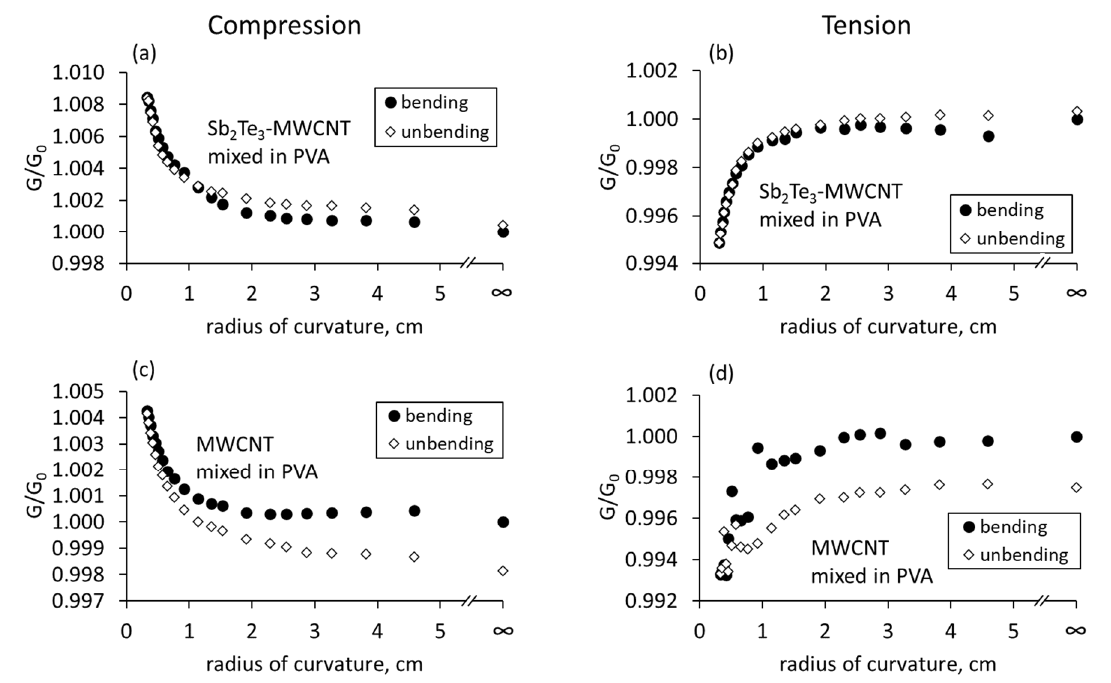
Figure 6. Relative changes in the electrical conductance of Sb 2 Te 3 -MWCNT heterostructures and bare MWCNT networks mixed in the PVA vs. its radius of curvature: ( a , c ) compressive stress; ( b , d ) tensile stress. G is the conductance of the bent flexible film, G 0 is the conductance of the not bent flexible film.